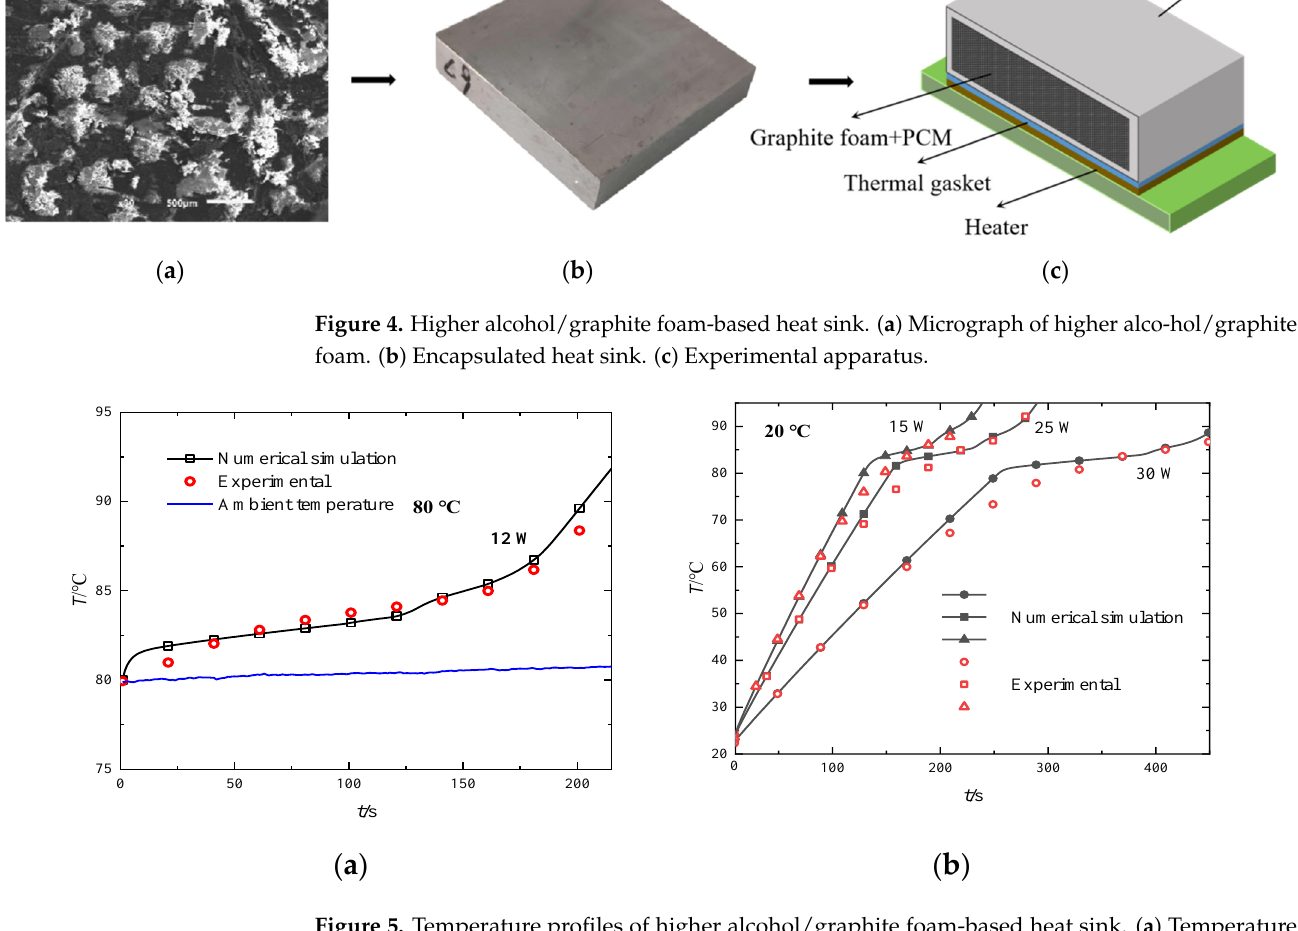
Figure 4. Higher alcohol/graphite foam-based heat sink. ( a ) Micrograph of higher alco-hol/graphite foam. ( b ) Encapsulated heat sink. ( c ) Experimental apparatus.